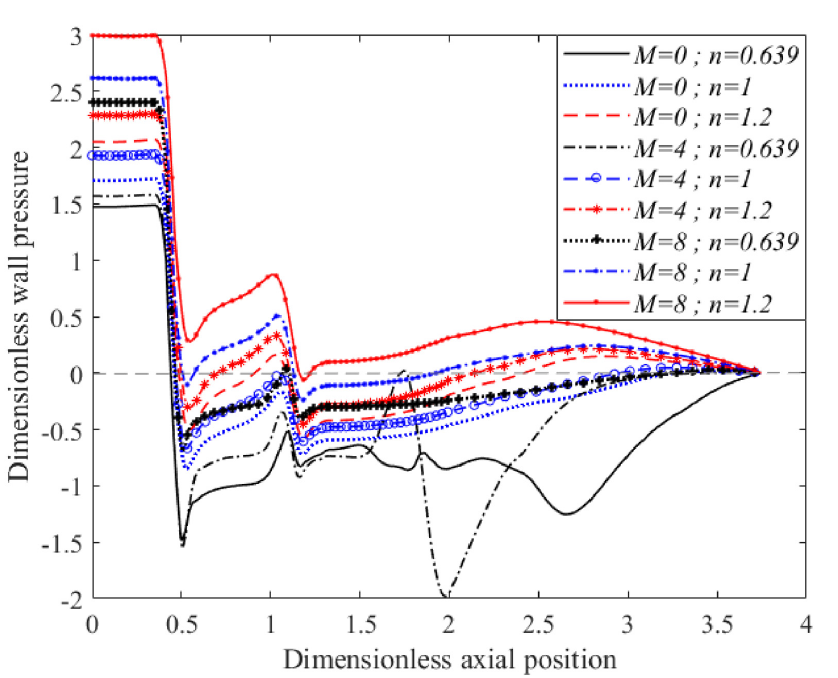
Fig 9. Wall pressure distribution along the outer arterial wall for different in Hartmann number and fluid = 0.4 a ). characterisation (Re = 300 and τ m